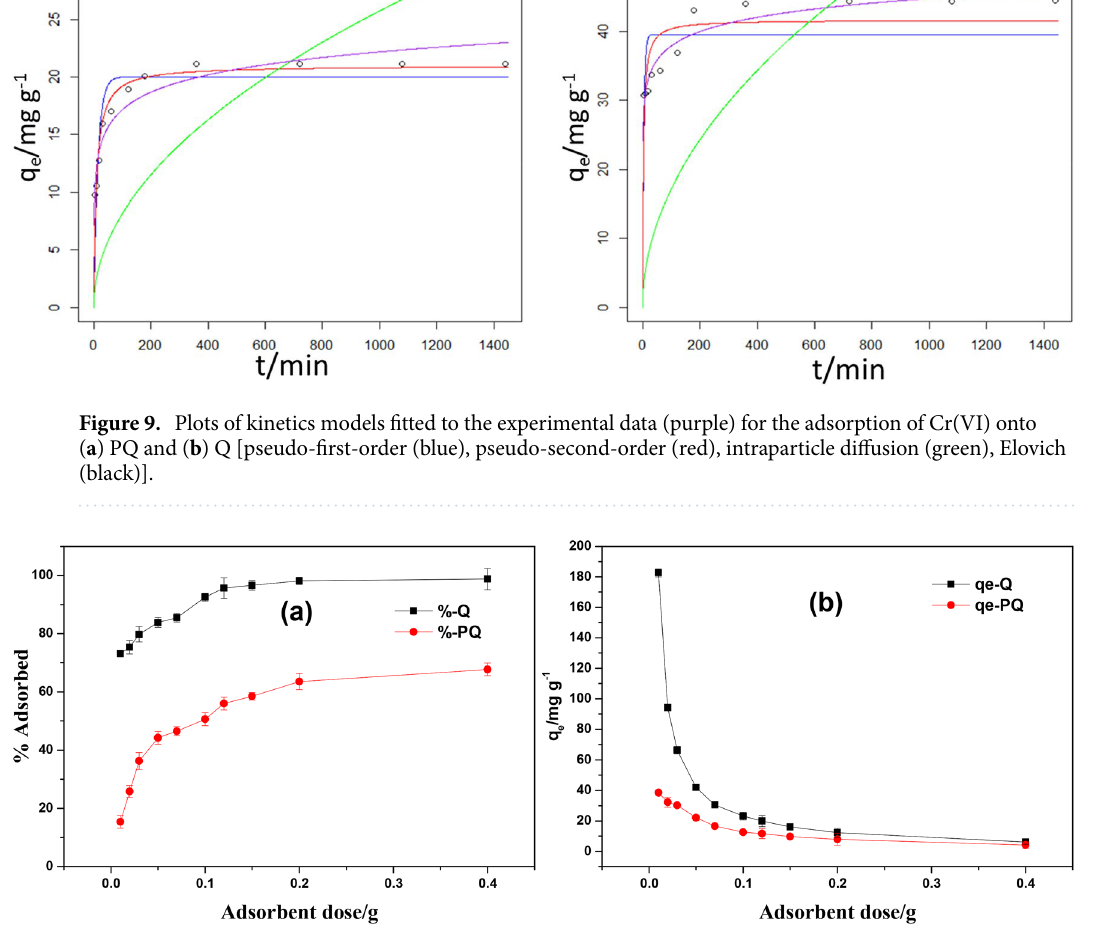
Figure 10. Effect of dosage on adsorption Cr(VI) onto PQ and Q ( a ) % adsorbed and ( b ) adsorption